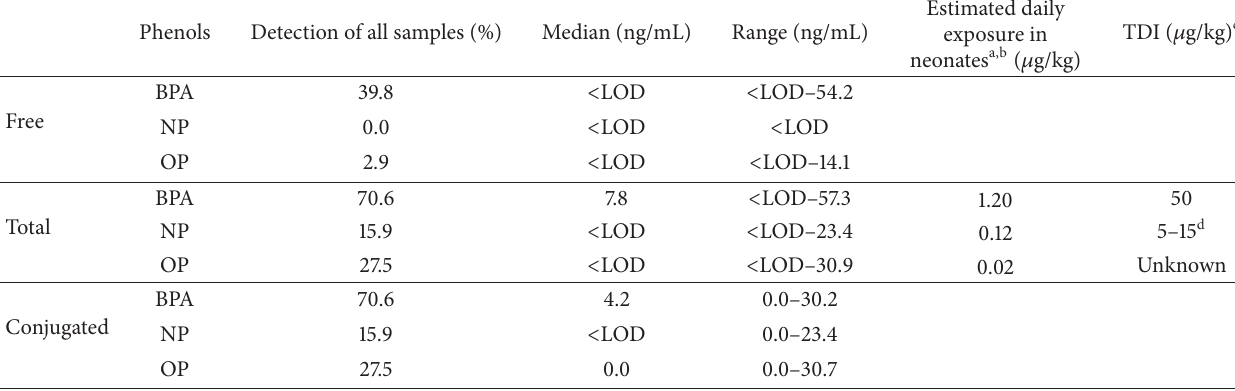
Table 2: Comparison between exposure levels and regulation levels of phenols.